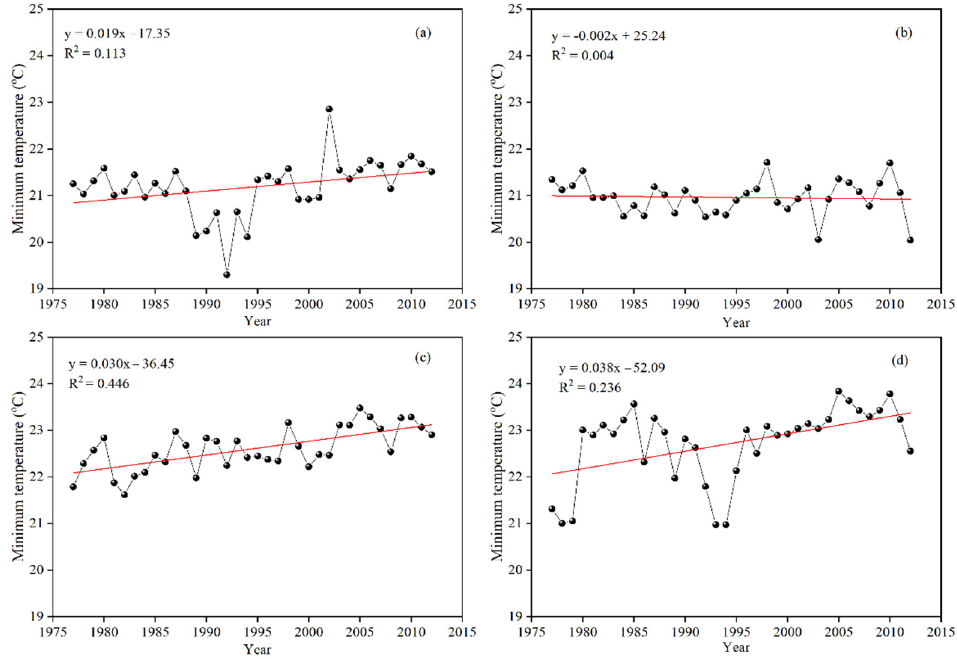
Figure 4. Annual minimum monthly temperature at ( a ) Kara, ( b ) Niamtougou, ( c ) Mango and ( d ) Dapaong. Figure 5 shows the long-term trend in the maximum temperature (T max ) at Kara, Niamtougou, Mango and Dapaong. The annual average T max from 1977 to 2012 at Kara, Niamtougou, Mango and Dapaong was 33.7, 32.4, 33.6, and 35.1 °C, respectively (Figure 5, Table 5). Annual average T max var- ied from 32.7 to 34.8 °C at Kara, from 31.7 to 33.2 °C at Niamtougou, from 34.3 to 36.2 °C at Mango and from 32.4 to 34.9 °C at Dapaong (Figure 5). There was an increasing trend in T max at Kara, Mango and Niamtougou, unlike Dapaong where T max showed a significant decreasing trend ( p < 0.1) (Table 5). T max increased by 0.13, 0.13 and 0.32 °C per decade at Kara, Niamtougou and Mango, respectively, and decreased by 0.20 per decade in Dapaong. These findings are consistent with that of the United States Geological Survey (USGS) [45], who assessed the climate trend in Burkina Faso (1975–2009) and indicated that temperature has increased by 0.15 °C per decade across most Burkina Faso. The results suggest that, due to these high temperatures and their increasing trend, it is likely that the